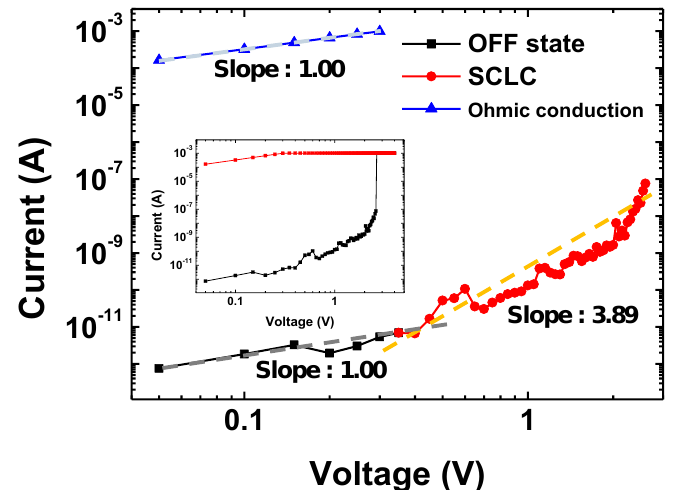
Figure 7. Experimental data and fitted lines of the I-V characteristics in the OFF state and ON state (Inset: original I-V characteristic of the ITO/PI-GO/Al device).